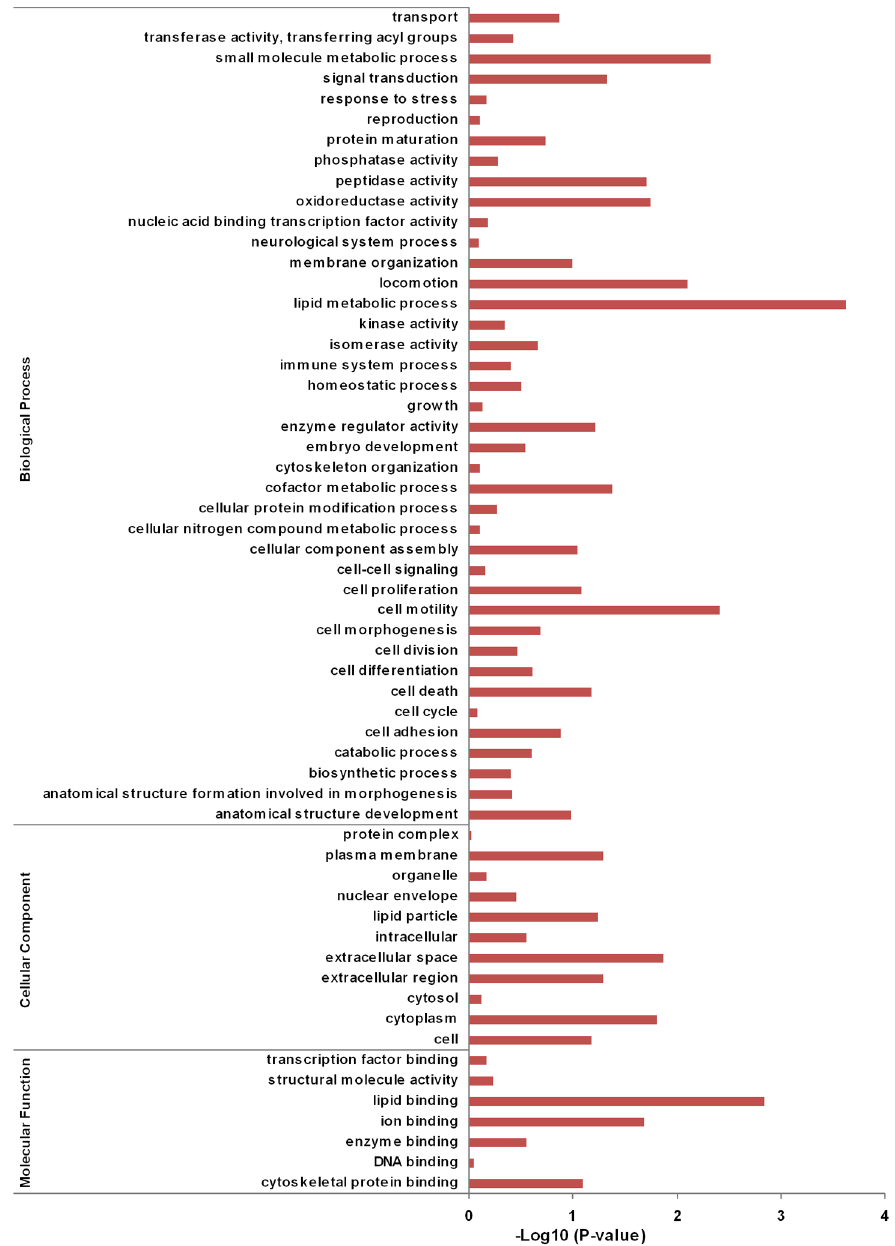
Figure 4. GO enrichment analysis of chGH-regulated mRNAs predicted to be targeted by GH-regulated miRNAs. The target mRNAs for GH up-regulated miRNAs were predicted in the GH down-regulated mRNAs; the target mRNAs for GH down-regulated miRNAs were predicted in the GH up-regulated mRNAs.